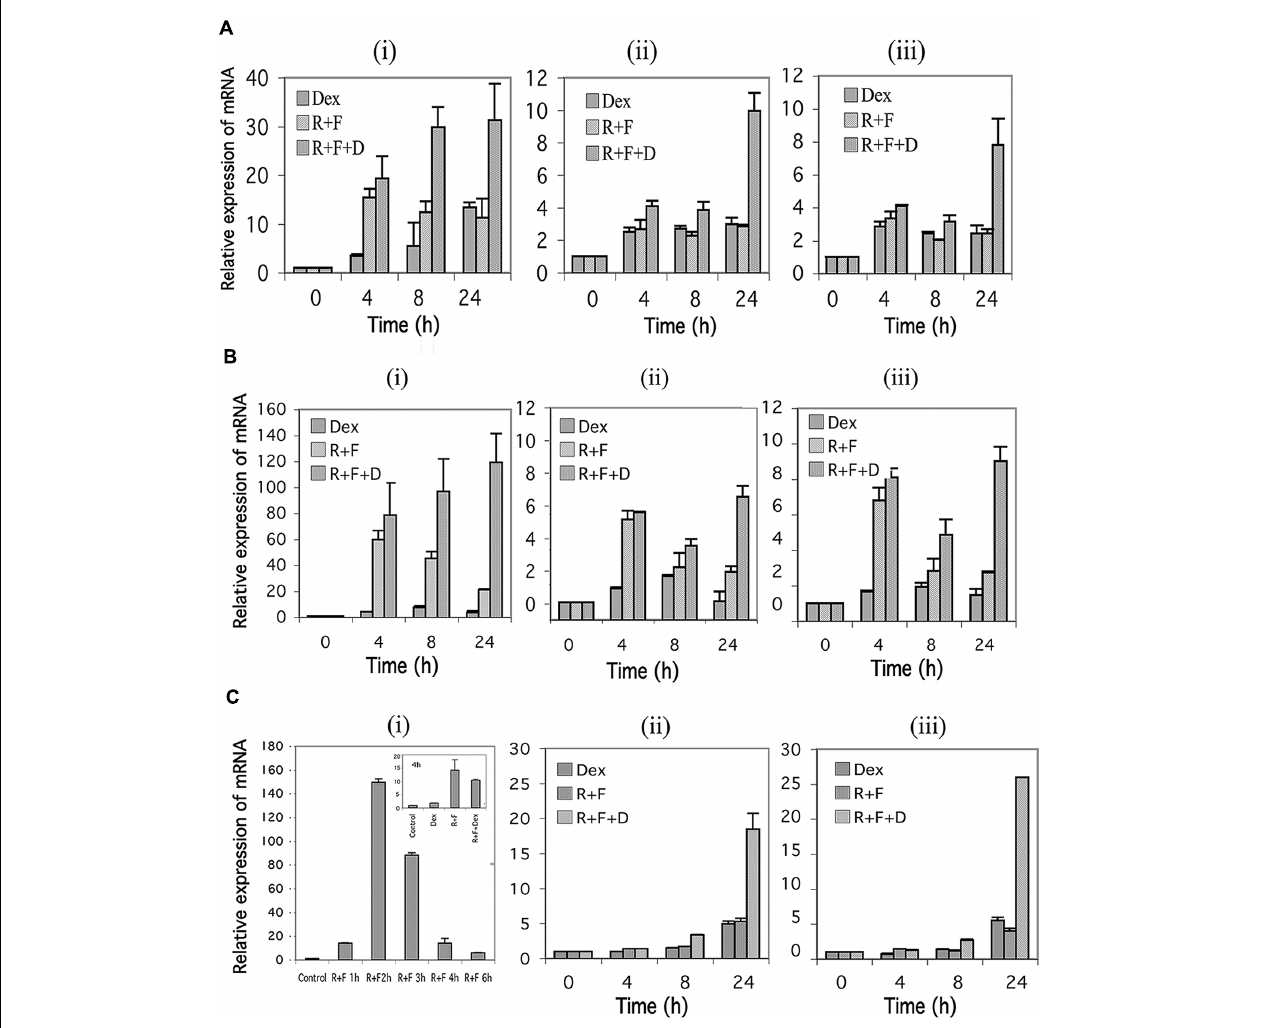
FIGURE 4 | Glucocorticoid receptor alpha (GR) promoter 1A, 1B, and 1C expression in CEM and MM.1 cells. Quantitative real-time PCR analysis of GR1A3, 1B and 1C mRNA expression in both CEM and MM.1 cells. (A) , GR1A3(i), 1B(ii), and 1C(iii) expression in CEM-S2 cells. (B) , GR1A3(i), 1B(ii), and 1C(iii) expression in CEM-R8 cells. (C) , GR1A3(i), 1B(ii), and 1C(iii) expression in MM.1S cells. Points were taken following treatment with 1 µ M dexamethasone (Dex), 10 µ M rolipram plus 10 µ M forskolin (R + F), or 1 µ M dexamethasone plus 10 µ M rolipram plus 10 µ M forskolin (R + F + D) for different times as indicated. Data represent the mean ± SD of at least two independent experiments assayed in